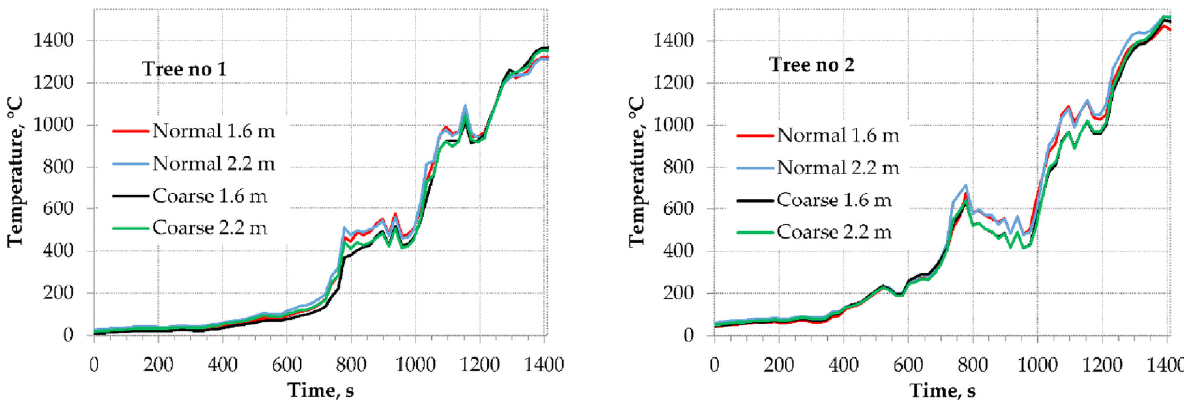
Figure 10. Numerical results for two mesh densities.